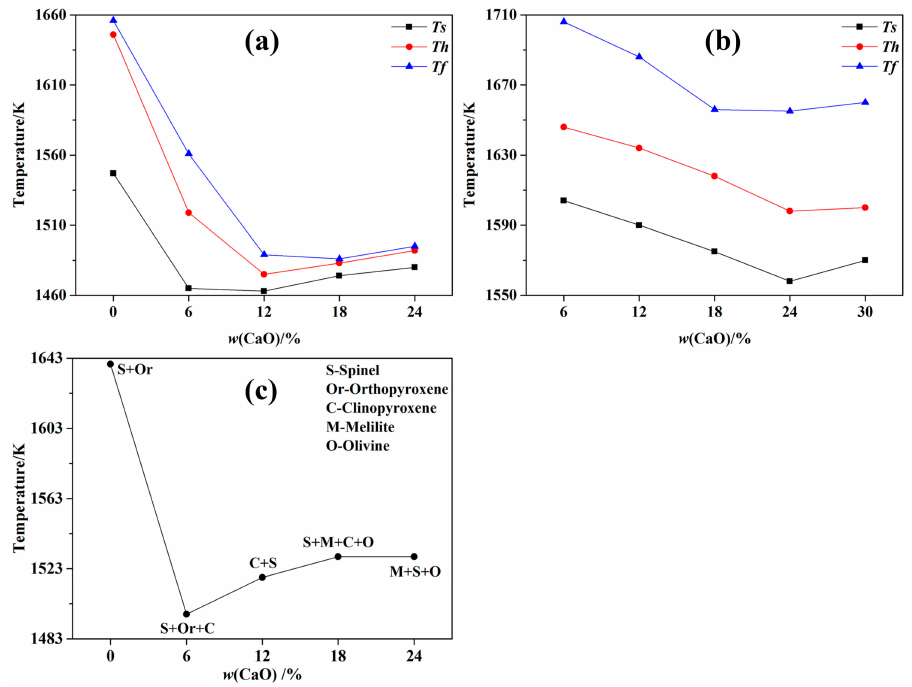
Figure 4. Effects of w (CaO) on fusion characteristic temperatures of the ( a ) synthetic slags, ( b ) nickel slags, and ( c ) calculated phase compositions at solidus